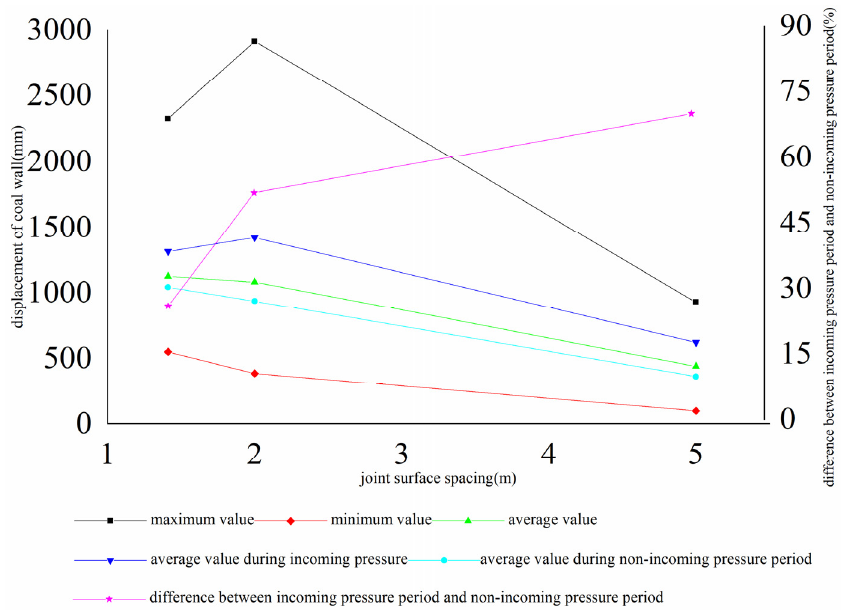
Figure 23. Coal wall Y-displacement change law with joint spacing ( α = 135°).